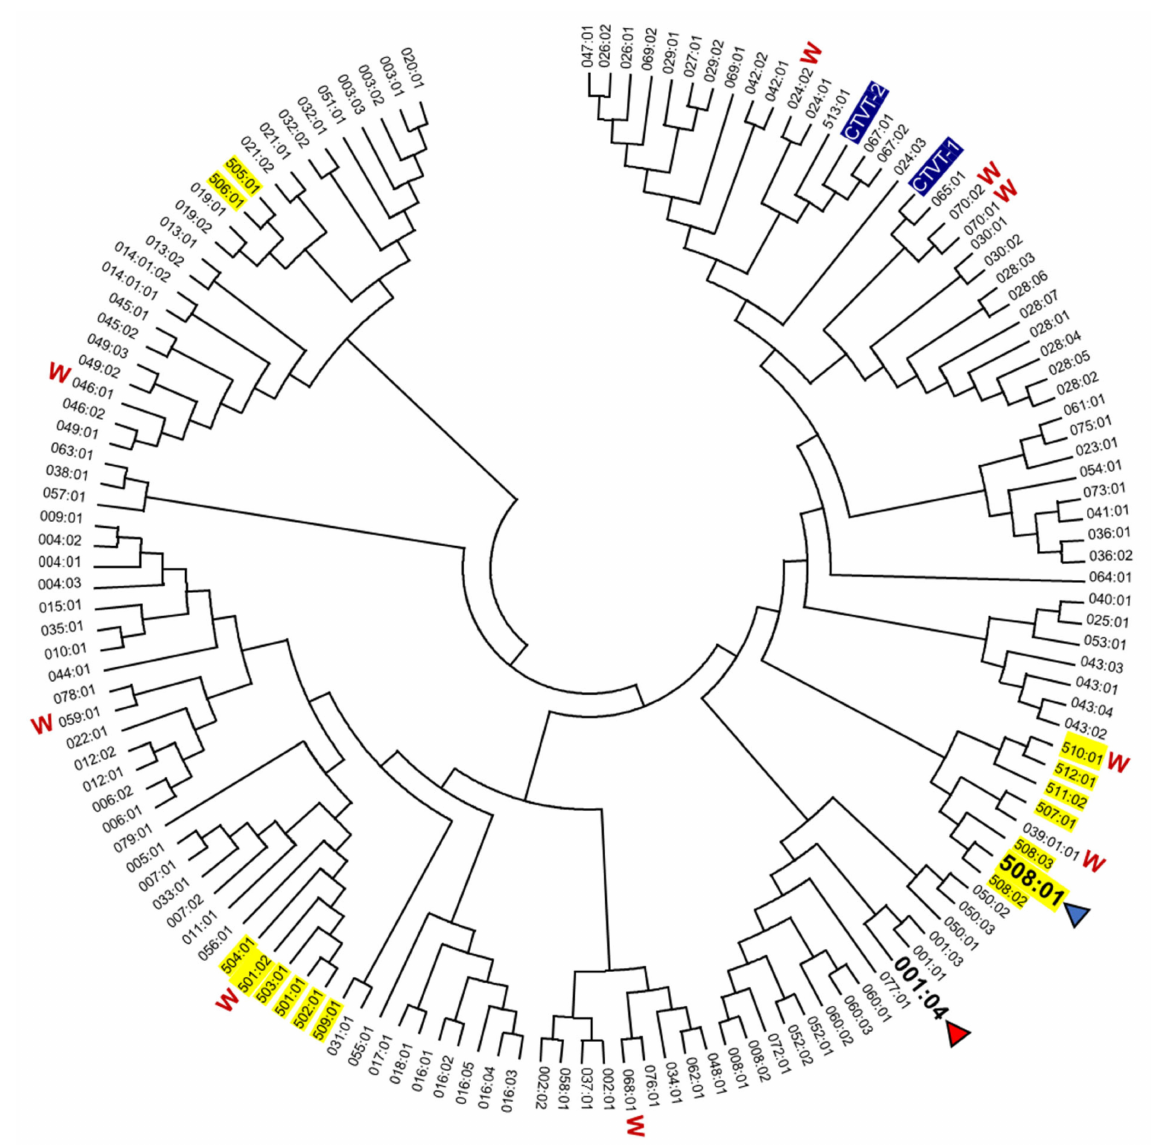
Figure 1. Phylogenetic relationship among DLA-88 alleles. The phylogeny of the α 1 + α 2 domains was estimated by Neighbor-Joining method for all DLA-88 alleles of dog and gray wolf (W) deposited in the IPD-MHC database. DLA-88 alleles for which the structure has been determined are highlighted with an arrowhead. DLA-88 alleles of the DLA-88*5 category are highlighted with yellow. For GenBank accession numbers of most DLA-88 alleles see the IPD-MHC database. Other GenBank accession numbers are: DLA-88*CTVT-1, AH015035; DLA-88*CTVT-2, AH015036. A few of the here compared sequences of the DLA-88*0 category may be expressed from the DLA-88L / DLA-12 locus [37]. The DLA-88 alleles *024:02 ([37] and GenBank LR890075), *039:01 [37,38], and *046:01 (GenBank AKS10581 and [38]) were reported for both dog and gray